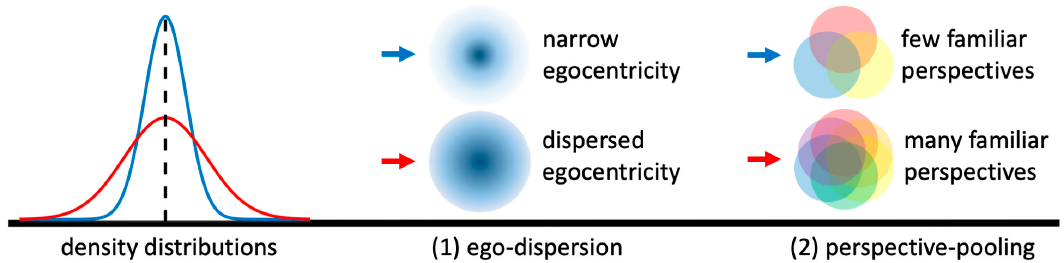
Figure 4. The two links, ego-dispersion and perspective-pooling. With increased state variability (Red > Blue) (1) egocentricity decreases (more blurring of the center of the circle from top to bottom) and (2) the number of self-experienced perspectives availabel for simulation increases (more coloured circles from top to bottom).